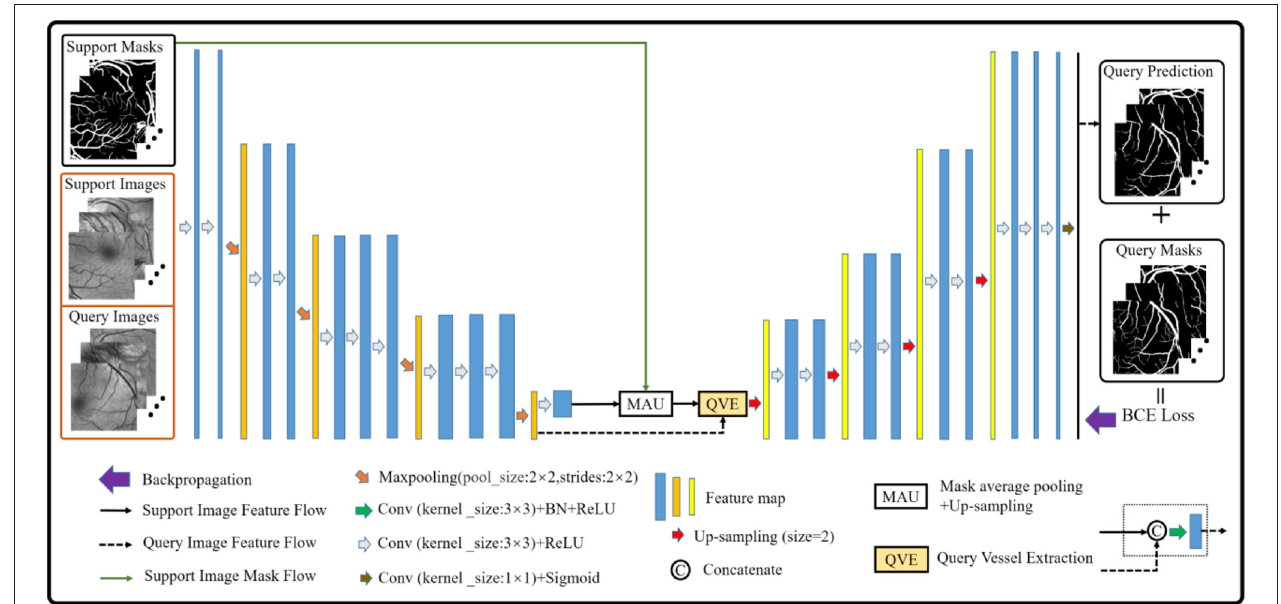
FIGURE 1 | An overview of the baseline